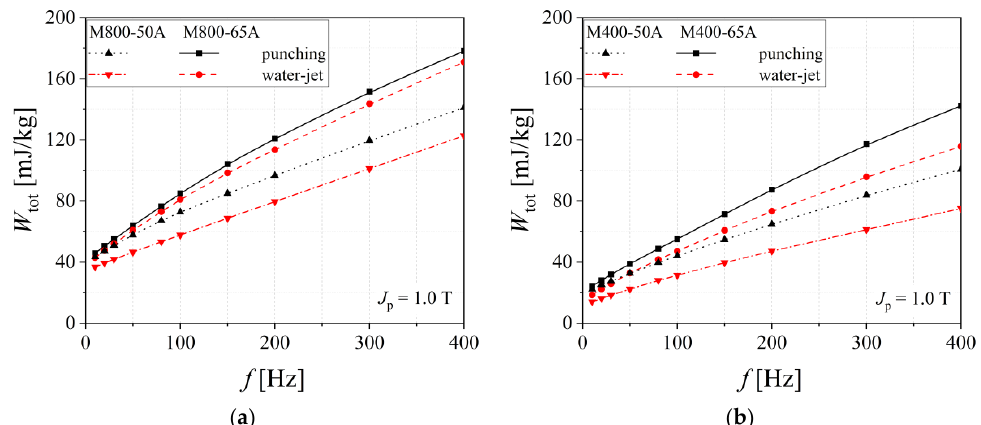
Figure 6. Total energy loss versus frequency measured at J p = 1.0 T of two electrical steel types ( a ) M800 and ( b ) M400, in the case of different sample thickness (0.50 mm and 0.65 mm).